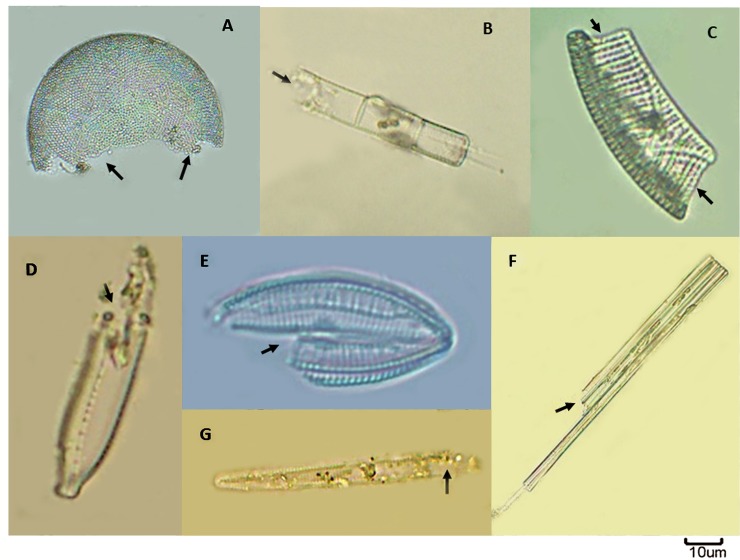
Broken phytoplankton cells.A-Coscinodiscus sp.; B-Aulacoseira sp.; C-Epithemia sp.; D-Hantzschia spp.; E-Mastogloia sp.; F-Fragilaria sp.; G-Synedra sp. The broken parts are indicated by arrow heads.